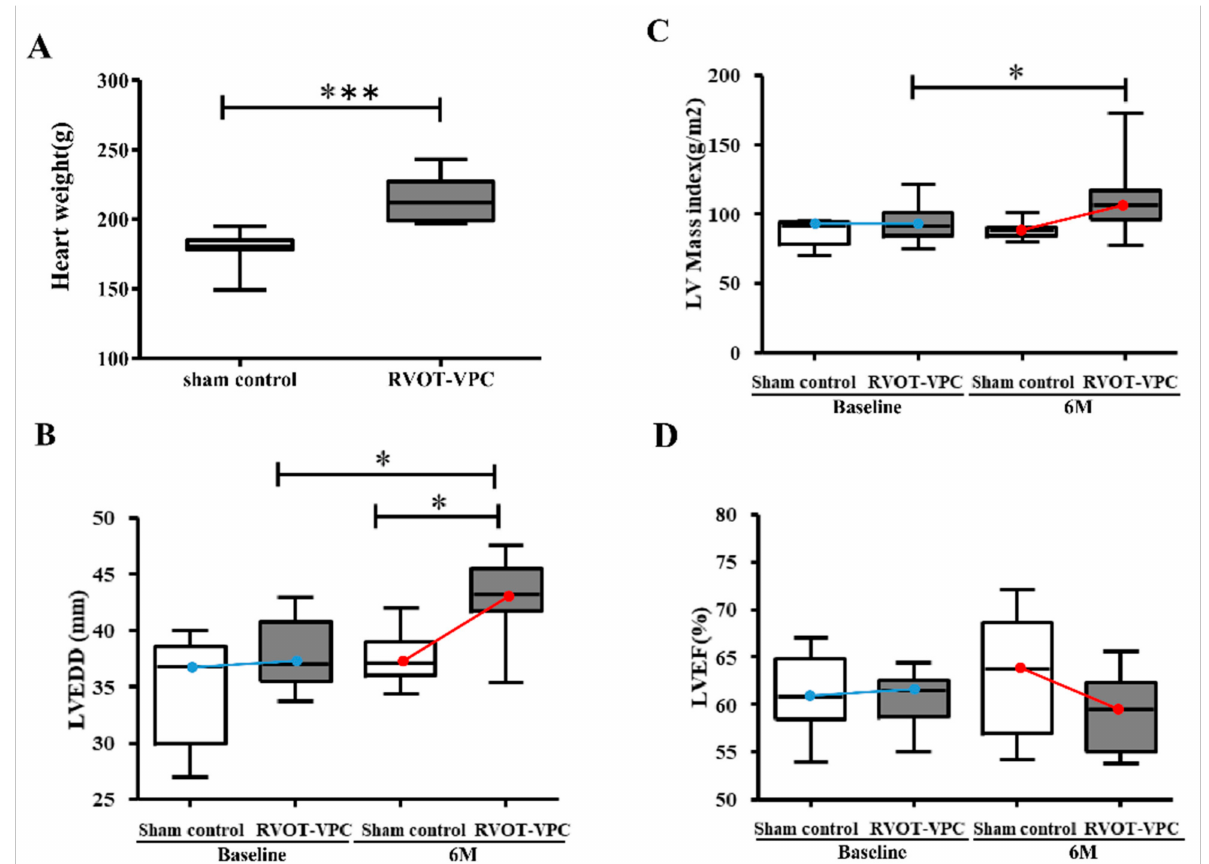
Figure 1. Heart weight, left ventricular mass, left ventricular size, and left ventricular ejection fraction between the RVOT- VPC group and the sham control group at baseline and 6-month follow-up. Heart weight of the RVOT-VPC group was bigger than the sham control group at the 6-month follow-up ( p < 0.001) ( A ). The left ventricular end-diastolic diameter (LVEDD) of the RVOT-PVC group at the 6-month follow-up was significantly larger than that of the RVOT-PVC group at the baseline ( p = 0.0022) and that of the sham control group at the 6-month follow-up ( p = 0.0101) ( B ). The LV mass index of the RVOT-VPC group was significantly higher than that of the sham control group at the 6-month follow-up ( p = 0.041) ( C ). There was a trend toward lower LV ejection fraction (LVEF) in the RVOT-PVC group compared to the sham control group at the 6-month follow-up ( D ). *: p < 0.05; ***: p < 0.001. Blue line to express the trend of difference between Sham control and RVOT-PVC groups at baseline; Red line to express the trend of difference between Sham control and RVOT-PVC groups at the 6-month